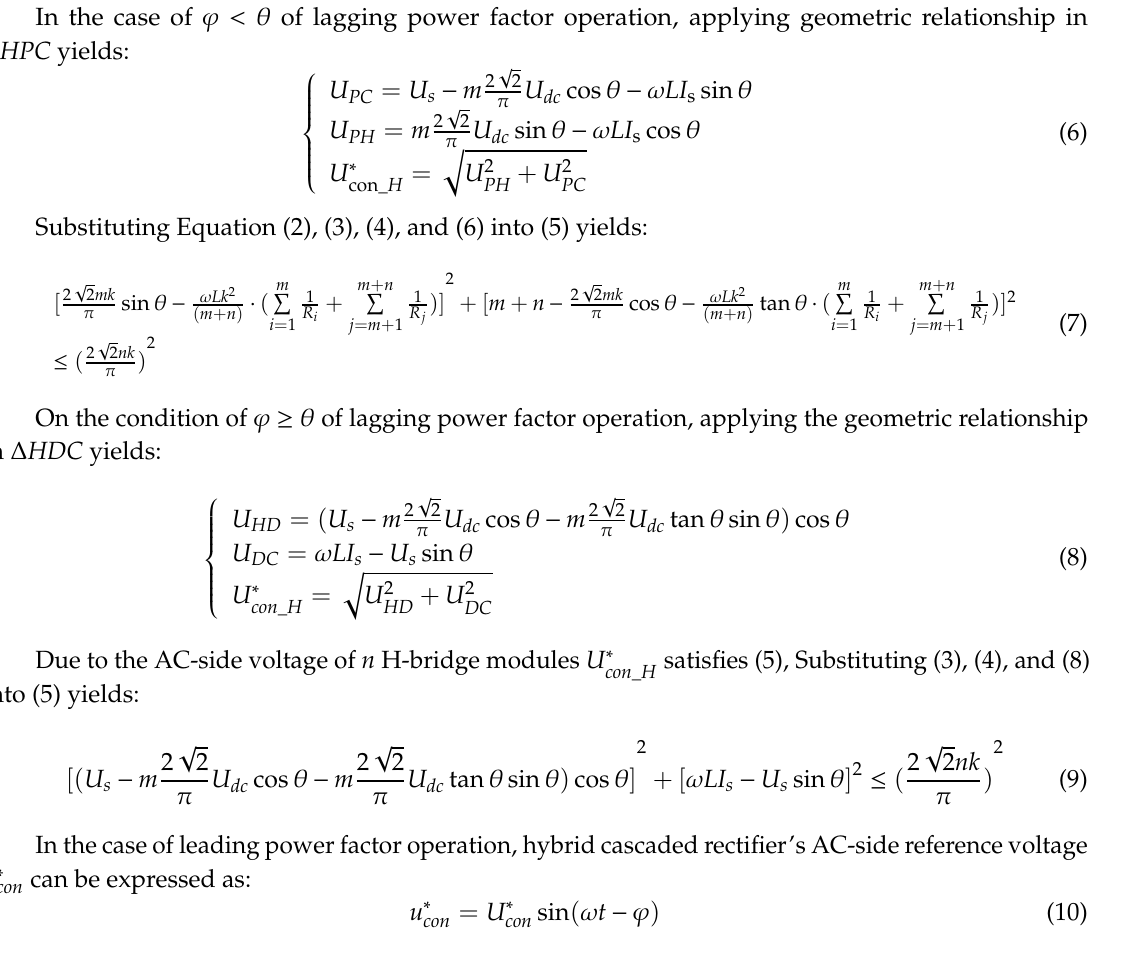
Figure 4. AC-side phasor diagram. ( a ) Lagging power factor angle ( ϕ < θ ); ( b ) lagging power factor angle ( ϕ ≥ θ ); ( c ) leading power factor angle.